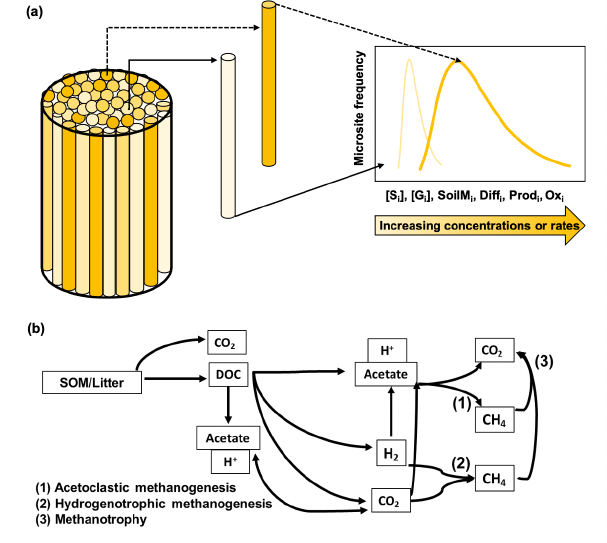
Figure 1. Conceptual figure of the modeling approach. Panel (a) shows the model representation of soil microsite distribution (modified from Sihi et al., 2020a; also see Eq. 14). The cylinder refers to the volume beneath the soil chambers. The intensity of different cylinder colors in the figure refers to rate of a process or the intensity of a concentration inside microsites in each theoretical cylinder; e.g., a dark color means a higher rate/intensity, and a light color means a lower rate/intensity for a given process. The 2D graph on the right refers to the probability density function of the rate of the process or intensity of the concentration in the bulk soil. A wide distribution skewed to the right (dark line) implies higher bulk rates of the process or higher concentrations, and a narrow distribution skewed to the left (light line) implies lower bulk rates of the process or lower concentrations, of any of the following: solute concentration [S i ], gas concentration [G i ], soil moisture (SoilM i ), gas and solute diffusion (Diff i ), methane production (Prod i ), and methane oxidation (Ox i ). Panel (b) is the schematic of the microbial-functional-group-based model for simulating soil methane (CH 4 ) dynamics in field soils (modified from Xu et al., 2015). The schematic represents the decomposition of soil organic matter (SOM) and plant litter into carbon dioxide (CO 2 ) and dissolved organic matter (DOC); the production of acetate and hy- dronium ion (H + ) from decomposition and fermentation of DOC, which also decreases pH; the production of acetate and hydronium ion (H + ) from homoacetogenesis, which decreases pH; and the production of dihydrogen ion (H 2 ) and CO 2 from decomposition of DOC. The intermediary products then have three possible non-mutually exclusive pathways: (1) aceticlastic methanogenesis, which is the production of methane from aqueous acetate found in soil solutions; (2) hydrogenotrophic methanogenesis, which is the production of methane from hydrogen; and (3) methanotrophy, which is the oxidation of methane into carbon